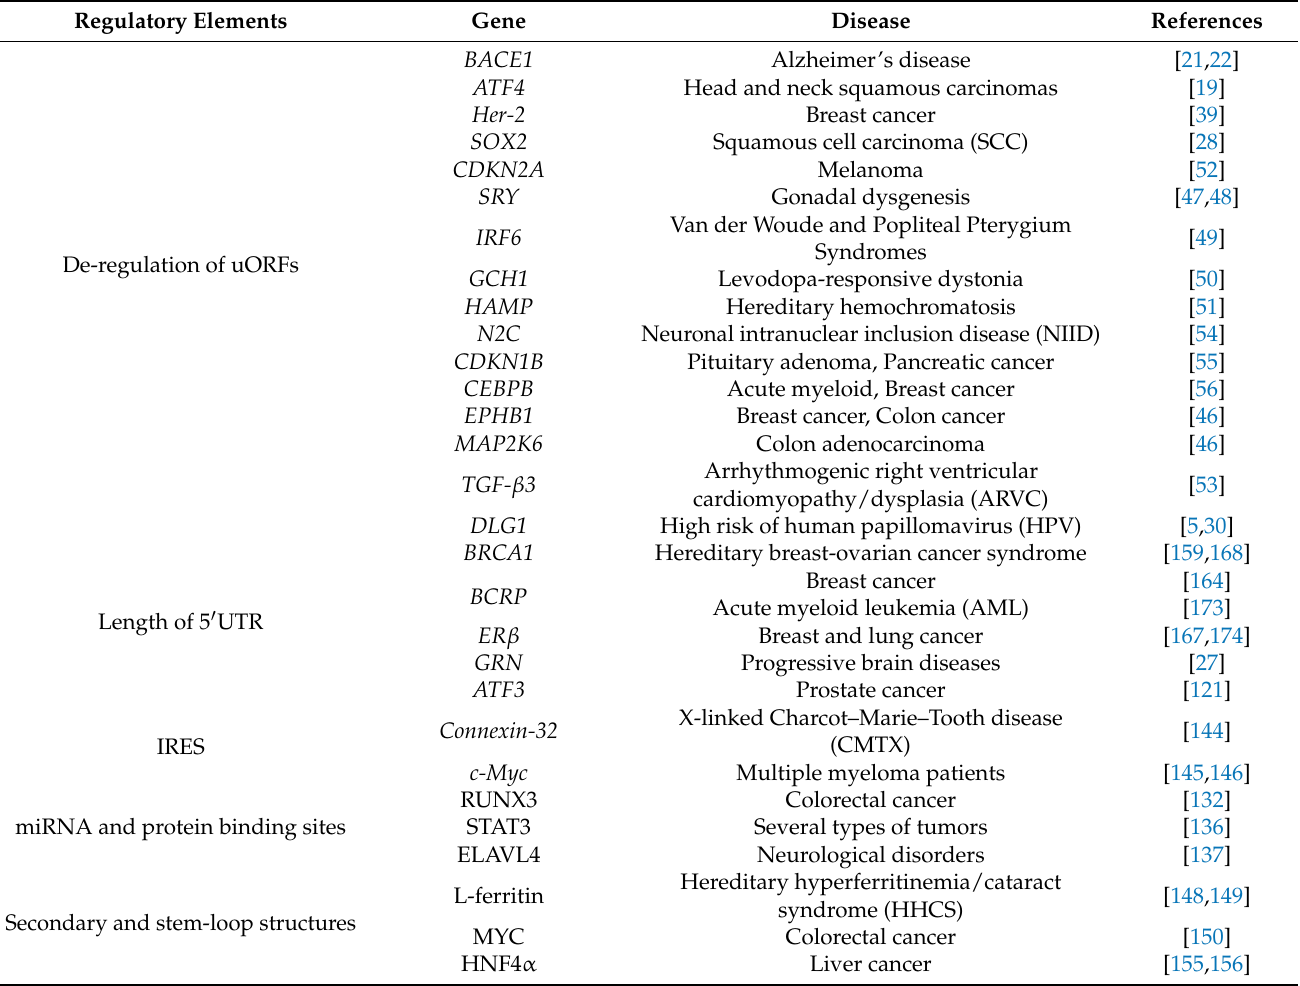
Table 1. List of genes that various regulatory elements of the 5 (cid:48) UTR are involved in diseases. Regulatory Elements